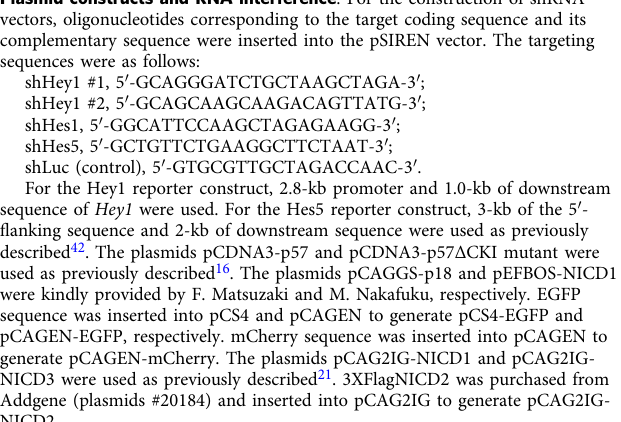
Fig. 6 The Hey1 promoter confers nonoscillatory expression dynamics. a RT and real-time PCR analysis of Hes/Hey and Actb ( β -actin) mRNA levels in cultured NPCs incubated in the presence of actinomycin D (5 µ M) for the indicated times. The amount of each mRNA was expressed relative to that